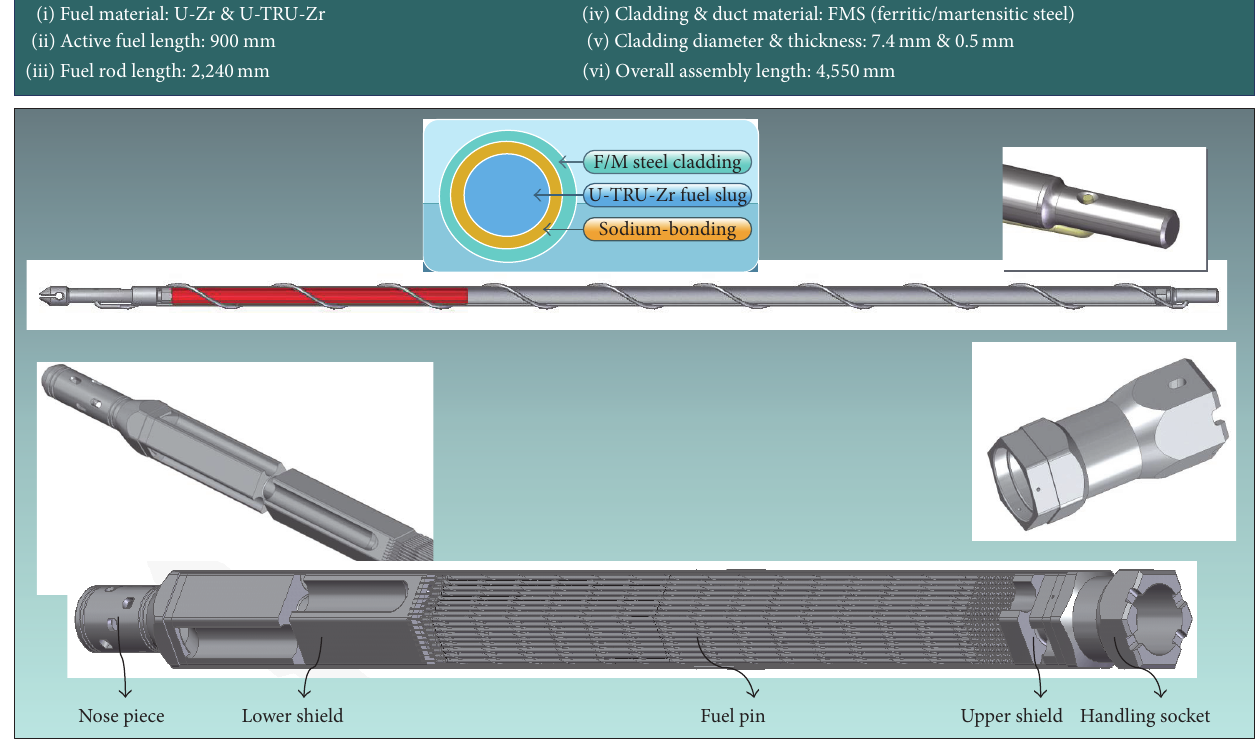
Figure 1: SFR metallic fuel. Table 1: Chemical composition of HT9